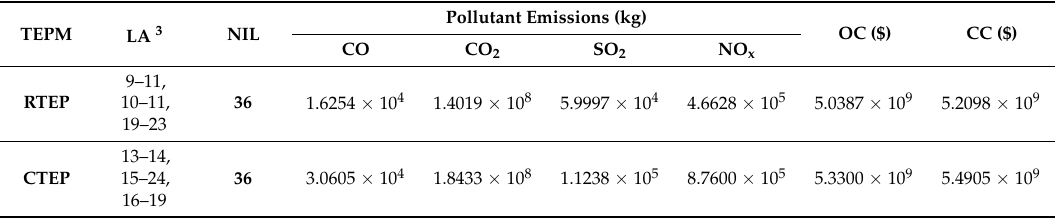
Table 7. Results of the proposed low-emission RTEP method and the CTEP method for the IEEE RTS-79